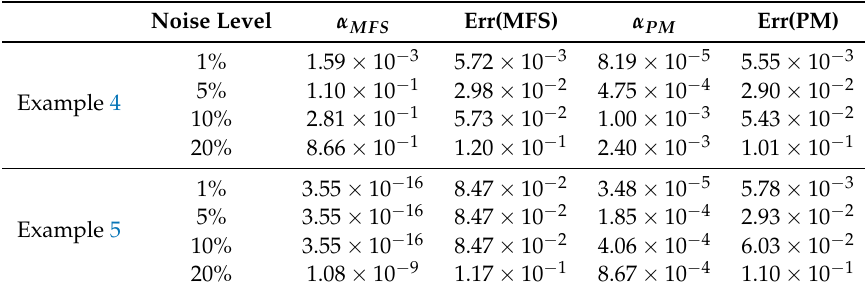
Table 2. The values of the regularization parameter, α , and the corresponding errors, E ∂ D ( f ) , obtained using the presented method, and various amounts of noise added in the boundary data, for Examples 4 and